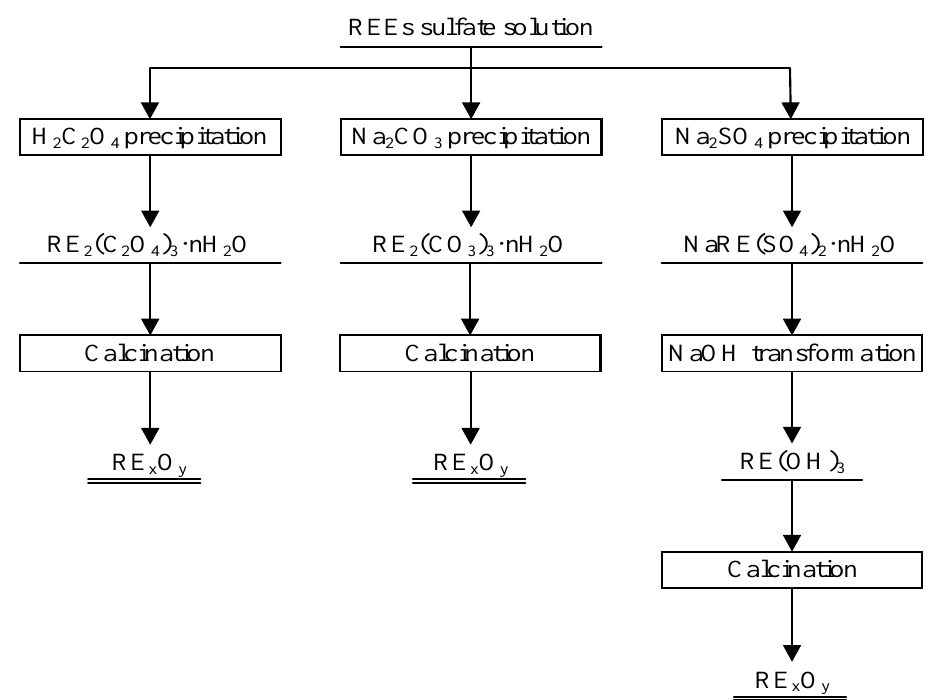
Figure 1. Proposed flowsheet for preparing RE x O y directly from water leaching solution after two-stage ammonium sulfate roasting.